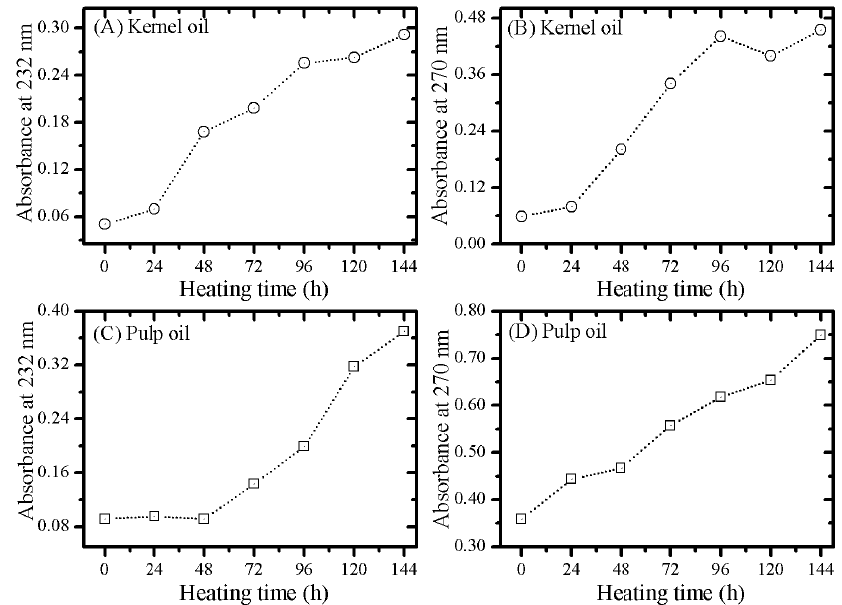
Figure 4. Absorbance of the kernel oil at ( A ) 232 nm and ( B ) 270 nm and the pulp oil at ( C ) 232 nm and ( D ) 270 nm as a function of the heating time. Dotted lines are only guides to the eyes. The oils were diluted in hexane at 0.75% ( w / v ) and 0.04% ( w / v ) for analysis at 272 and 230 nm, respectively.